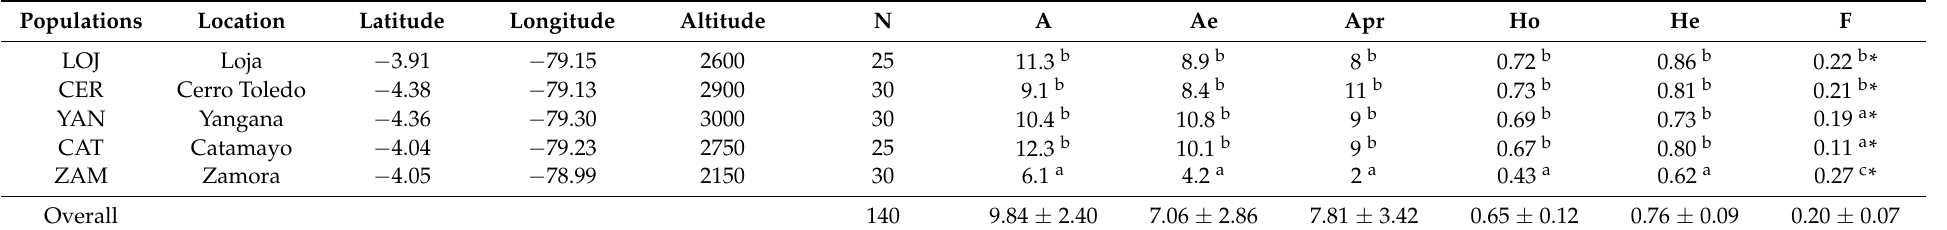
Table 2. Genetic diversity of Ocotea rotundata per population. Different superscript letters indicate significant differences between populations after a post hoc Tukey’s test ( p <